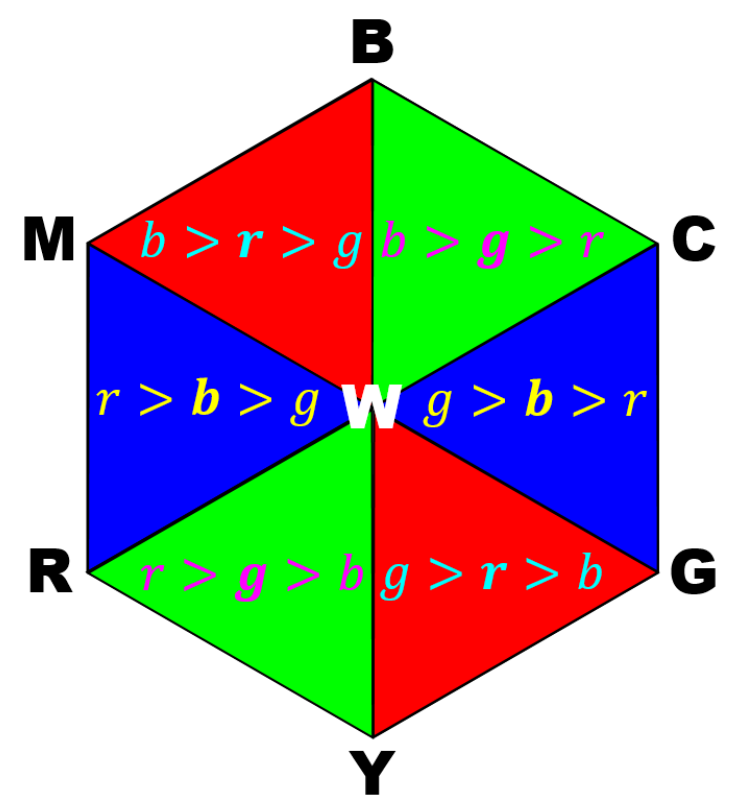
Figure 5. The proposed boundary surface in RGB color space viewed from the white point makes a regular hexagon, which is composed of six regular triangles painted in red, green and blue, separately. A color p = [ r , g , b ] T falls in one of the triangles, and satisfies the inequality written in the corresponding triangle. For example, if p is orthographically projected onto the top-left red triangle BMW, then we have b > r > g